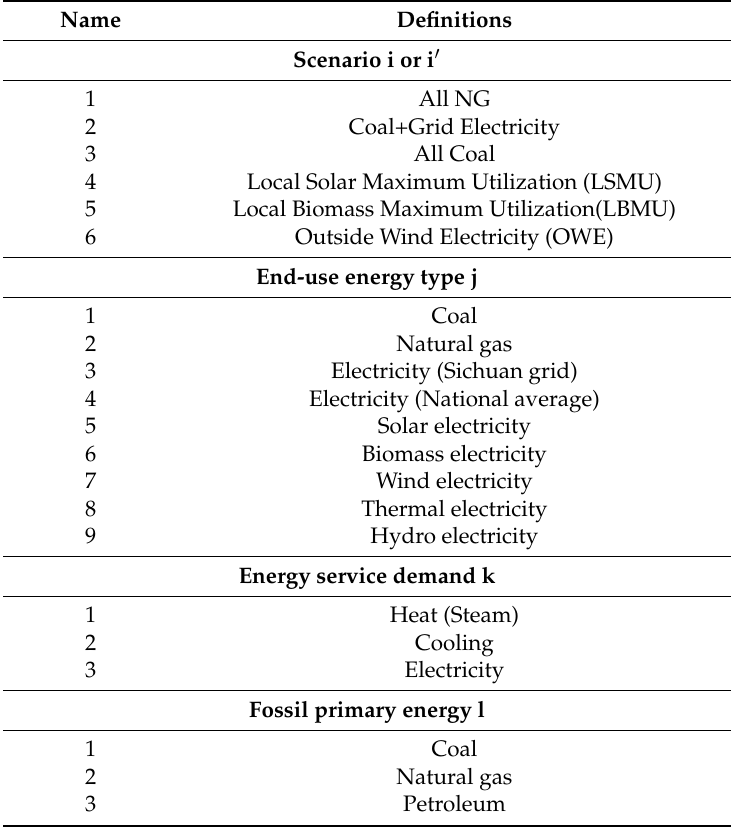
Table 3. Key variables related to LCA in this